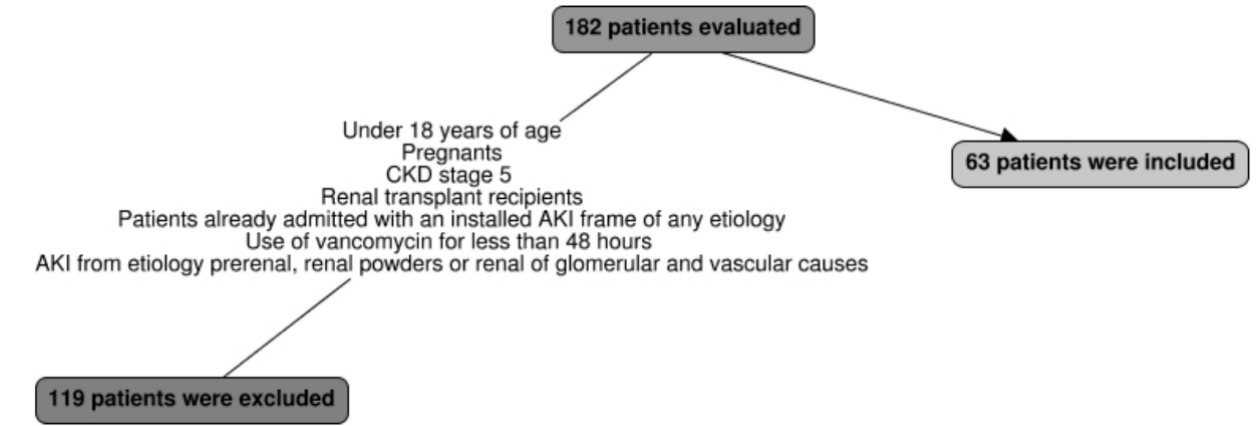
Figure 1. Flow diagram of patients included and excluded.